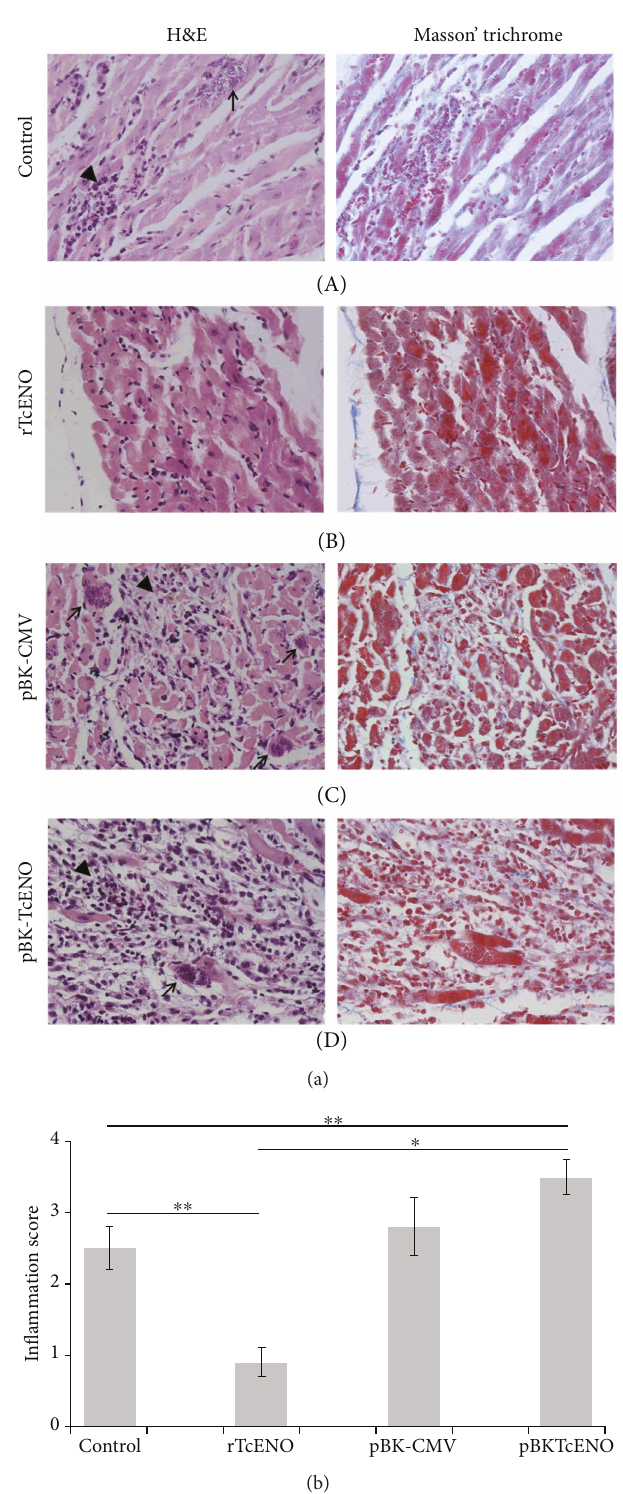
Figure 6: Vaccination e ff ects on the cardiac muscle sections. (a) Tissue sections were stained with hematoxylin and eosin or Masson ’ s trichrome and visualized by light microscopy (original magni fi cation: 40x). Representative micrographs of the heart tissue from control- infected mice and mock-immunized with PBS (A), rTcENO (B), pBK-CMV empty plasmid vector (C), and pBK-TcENO (D) are shown. Black arrows show amastigote nests. Black arrowheads show in fl ammatory in fi ltrates. (b) In fl ammatory lesion (lymphocyte in fi ltrates) scores. The in fl ammatory score was derived from two di ff erent experiments as described in Materials and Methods. The data are expressed as mean ± SD, and signi fi cance is presented as ∗ p < 0 01 and ∗∗ p < 0 05 ( ∗∗ control group nonimmunized and infected versus vaccinated and infected groups, rTcENO and pBK-TcENO; ∗ rTcENO versus